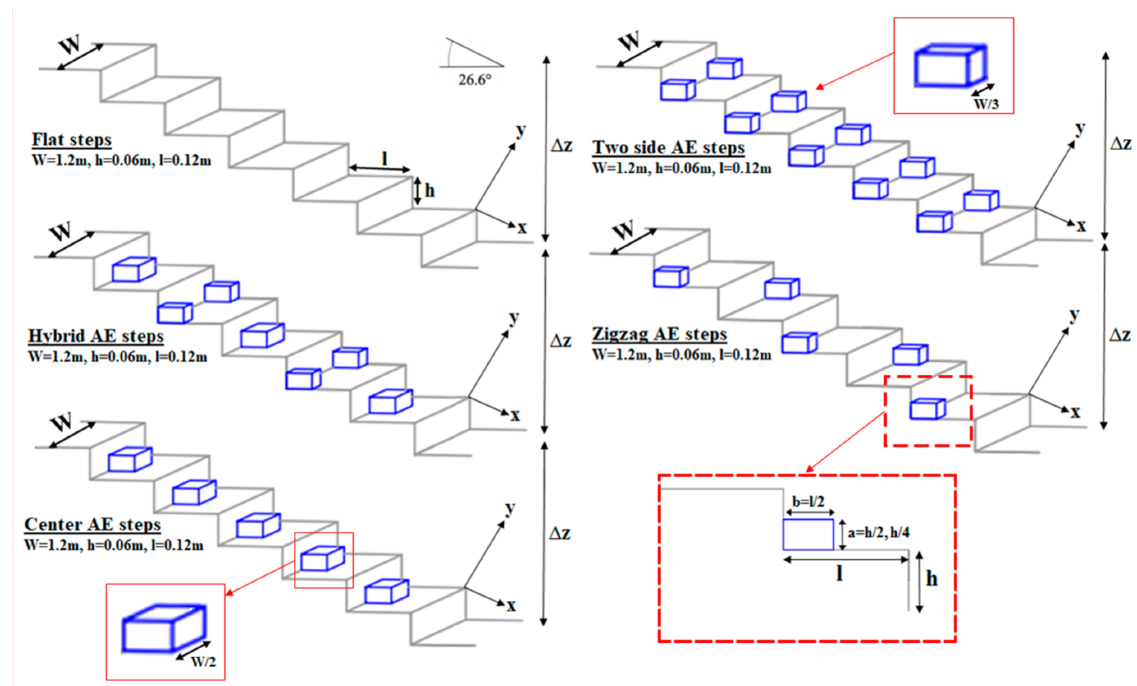
Figure 5. Stepped spillway configurations with flat and appendance elements (AE) on steps ( θ = 26.60 ◦